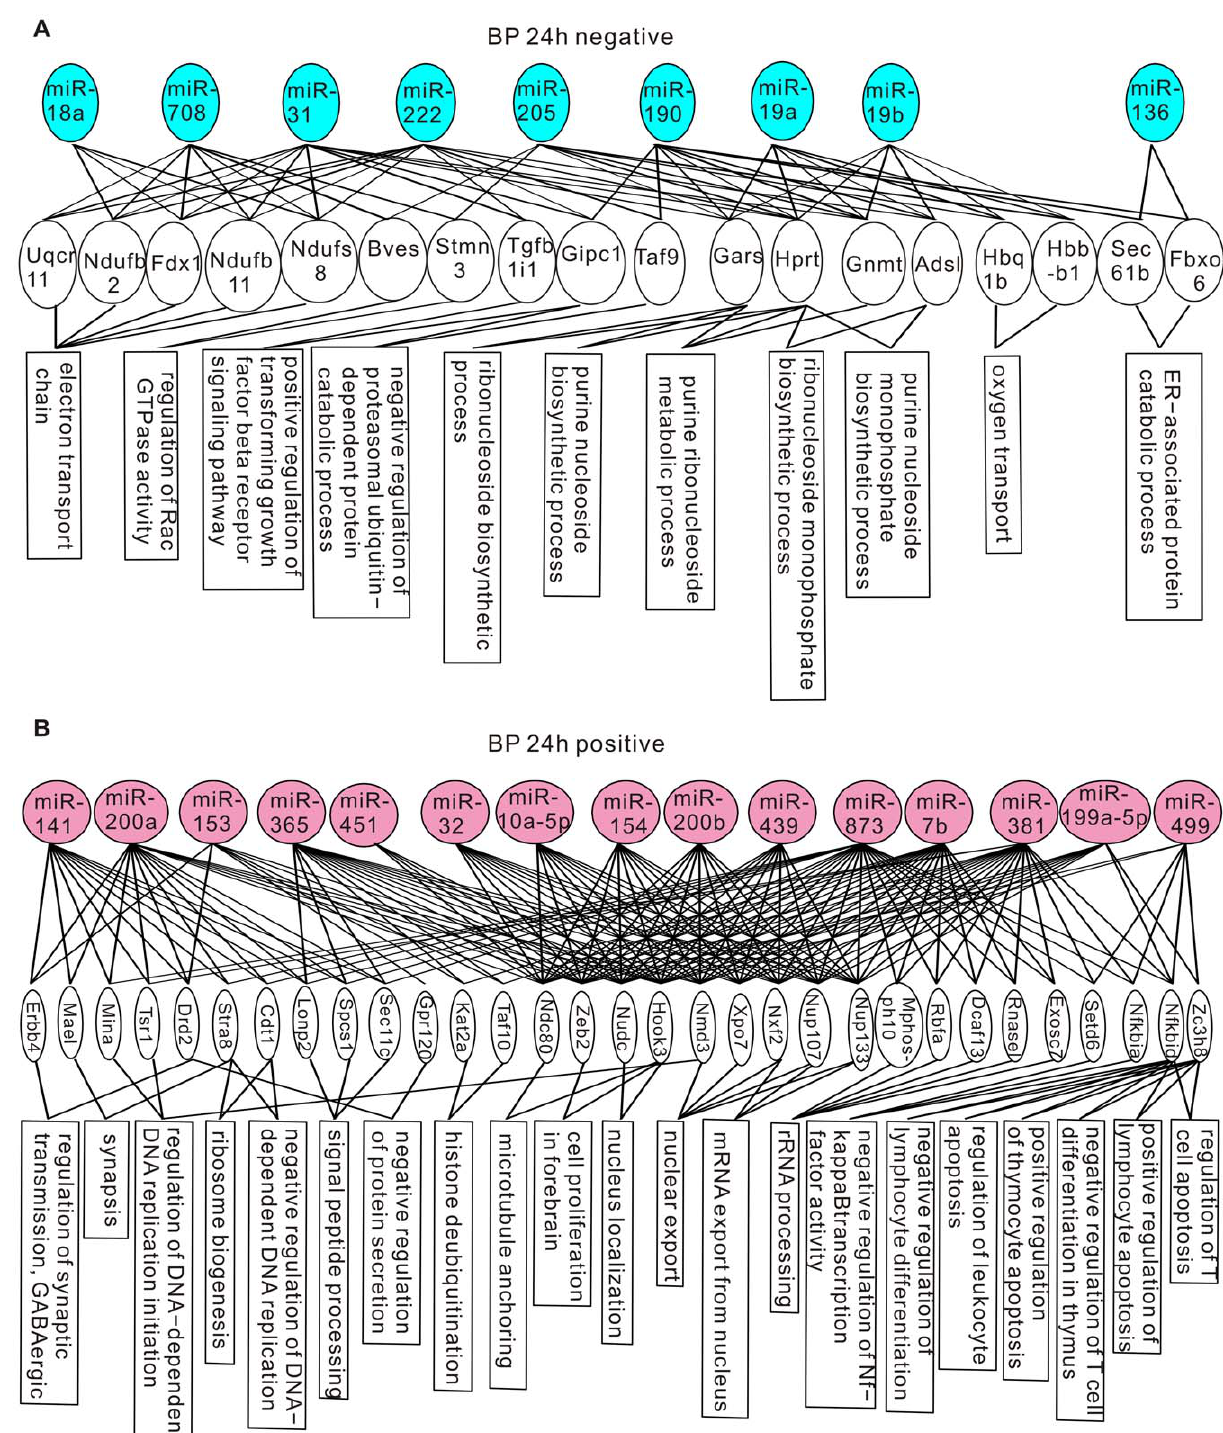
Figure 3. Genes and GO terms in the biological process ontology that are over-represented by differentially expressed miRNAs at 24 hours post-CCI. (A) Genes and GO terms enriched by down-regulated miRNAs. (B) Genes and GO terms enriched by up-regulated miRNAs.